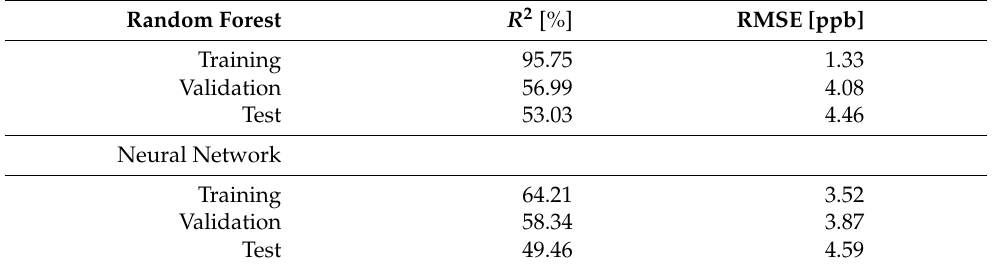
Table 3. Coefficient of determination and RMSE for the training and validation test set.